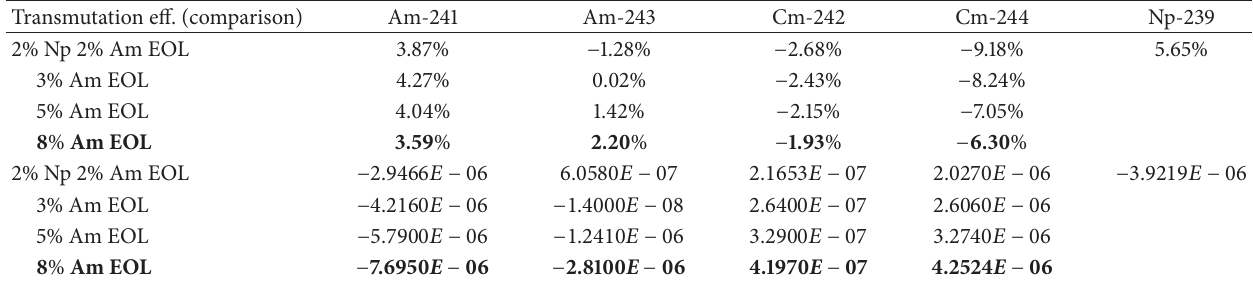
Table 1: Comparison of the transmutation efficiency between the reference cases without and the cases with moderating material for the different transmutation